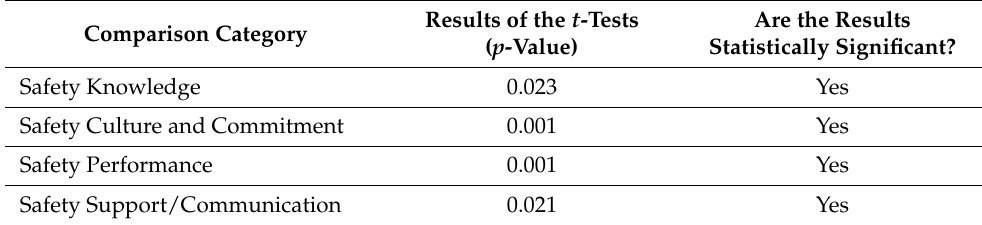
Table 7. Results of comparing workers’ self-assessment with managers’ assessment of workers. Comparison